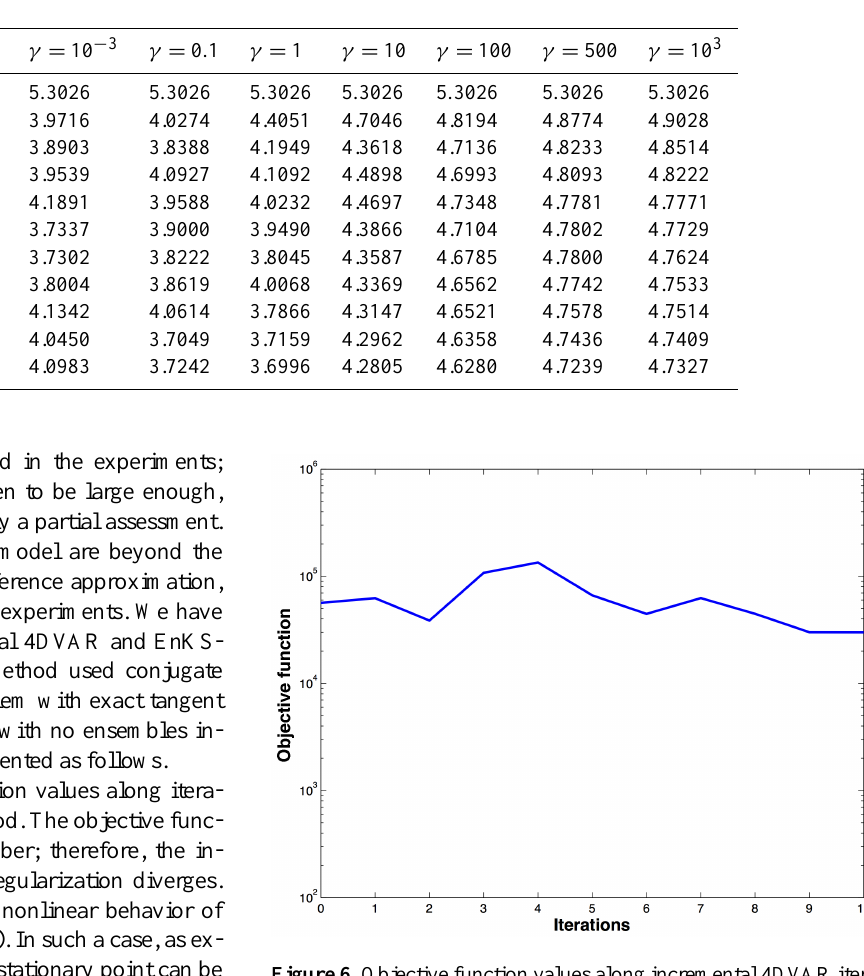
Figure 6. Objective function values along incremental 4DVAR iter- ations for the two-level quasi-geostrophic problem from Sect.